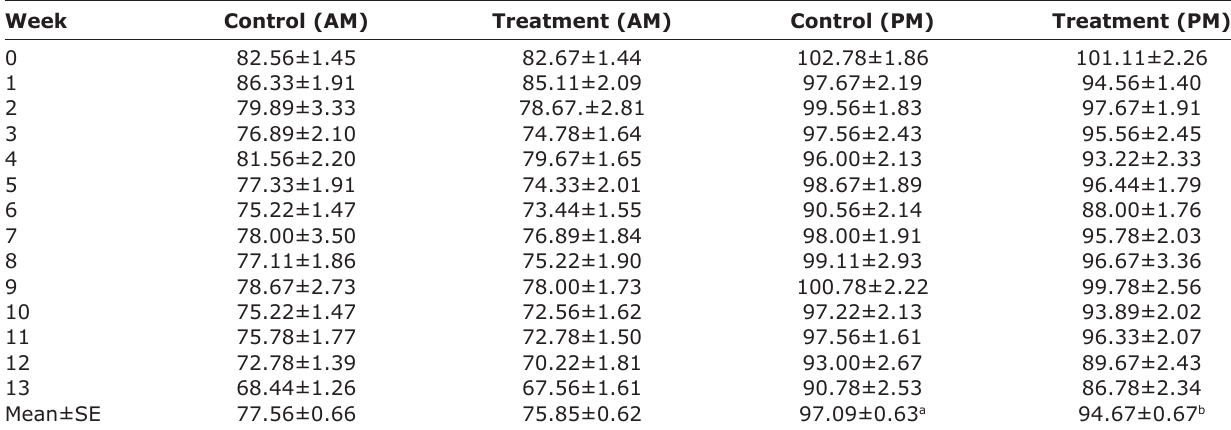
Table-5: Weekly morning (AM) and afternoon (PM) pulse rate (beats/minute) in KF